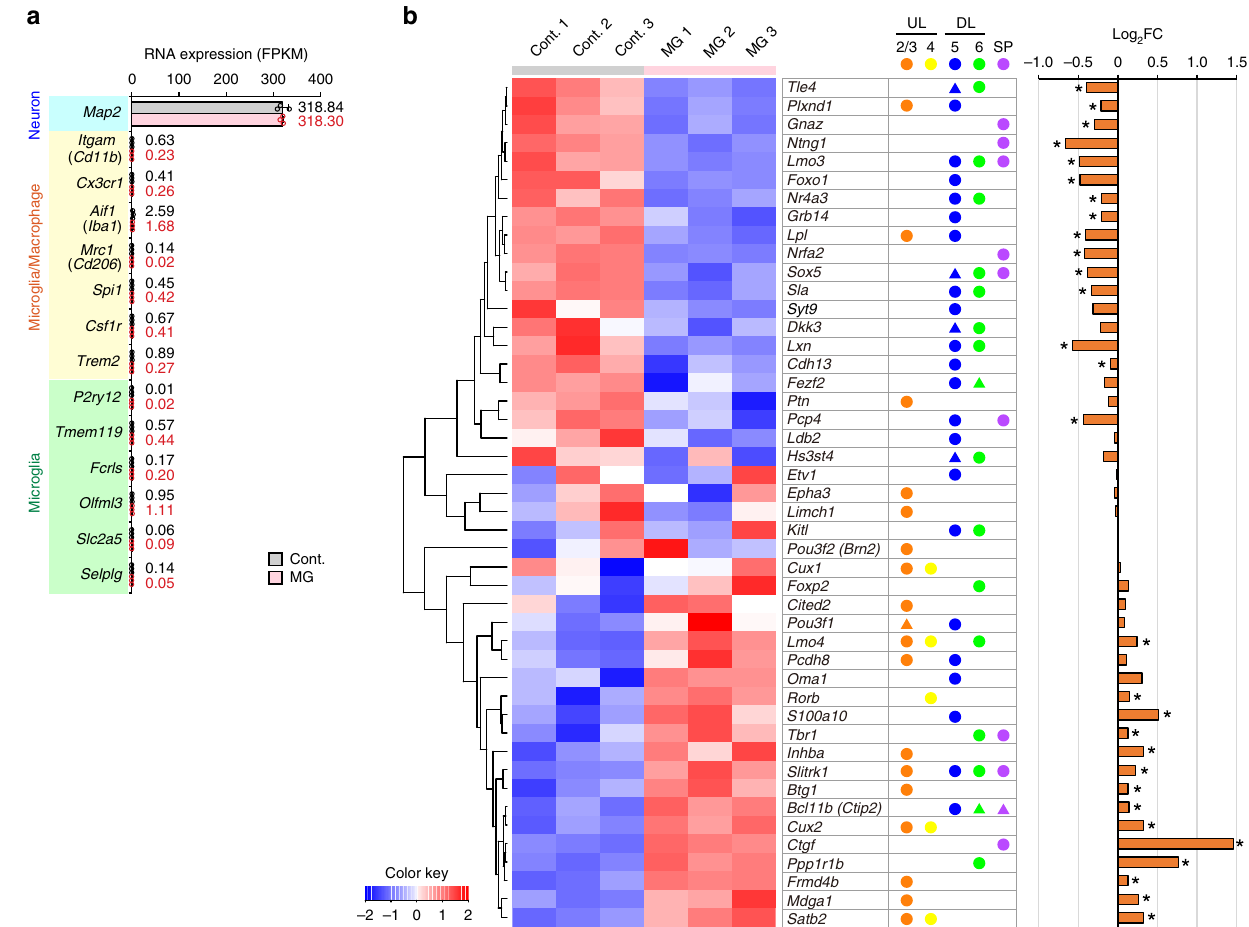
Fig. 7 Microglia widely disturbed the expression of transcription factors and molecules essential for the functional maturation of cortical neurons. a A comparison of the FPKM values of the neuron-speci fi c marker gene (MAP2) and several genes known as common microglial and macrophage markers (shown in yellow) and microglia-speci fi c markers (green) between neurons Cont and neurons MG . The black and red numbers beside the bar graph show the FPKM values for each gene in neurons Cont and neurons MG , respectively ( n = 3 samples obtained from independent cell cultures). Data are presented as the mean values ± S.D. b A heat map of 46 principal genes, which are uniquely expressed in particular cortical layer(s) and important for neuronal differentiation, showing the neurons MG /neurons Cont expression ratio. The middle panel shows the cortical layer identity (L2/3, L4, L5, L6, and SP [subplate]) of each gene. Circle shows that the gene is known to be strongly expressed in the corresponding layer; triangle shows its weak expression (see Supplementary Table 2). The right panel indicates the log 2 fold change (FC) of gene expression (neurons MG /neurons Cont ). FDR < 0.1 is considered signi fi cant (*). Source data and the exact FDR values are provided as a Source Data File and Supplementary Data